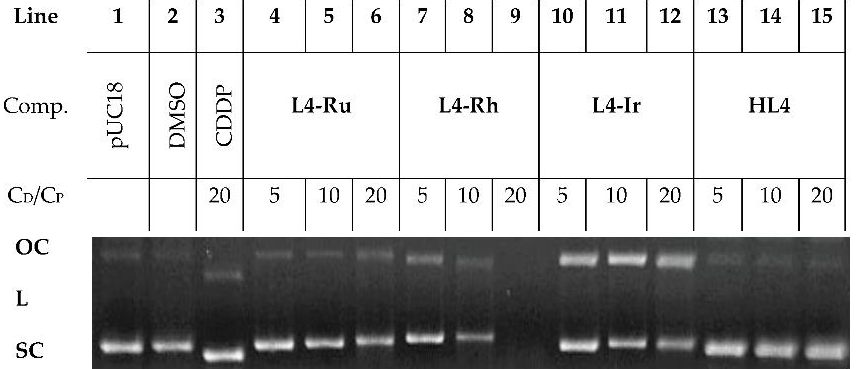
Figure 8. Electrophoresis mobility assay of pUC18 (20 µM) with DMSO (lane 2), cisplatin (lane 3), L4-Ru (lanes 4 – 6), L4-Rh (lanes 7 – 9), L4-Ir (lanes 10 – 12) and HL4 (lanes 13 – 15) at different C D /C P ratios. SC: supercoiled, OC: open circular and L: linear forms.